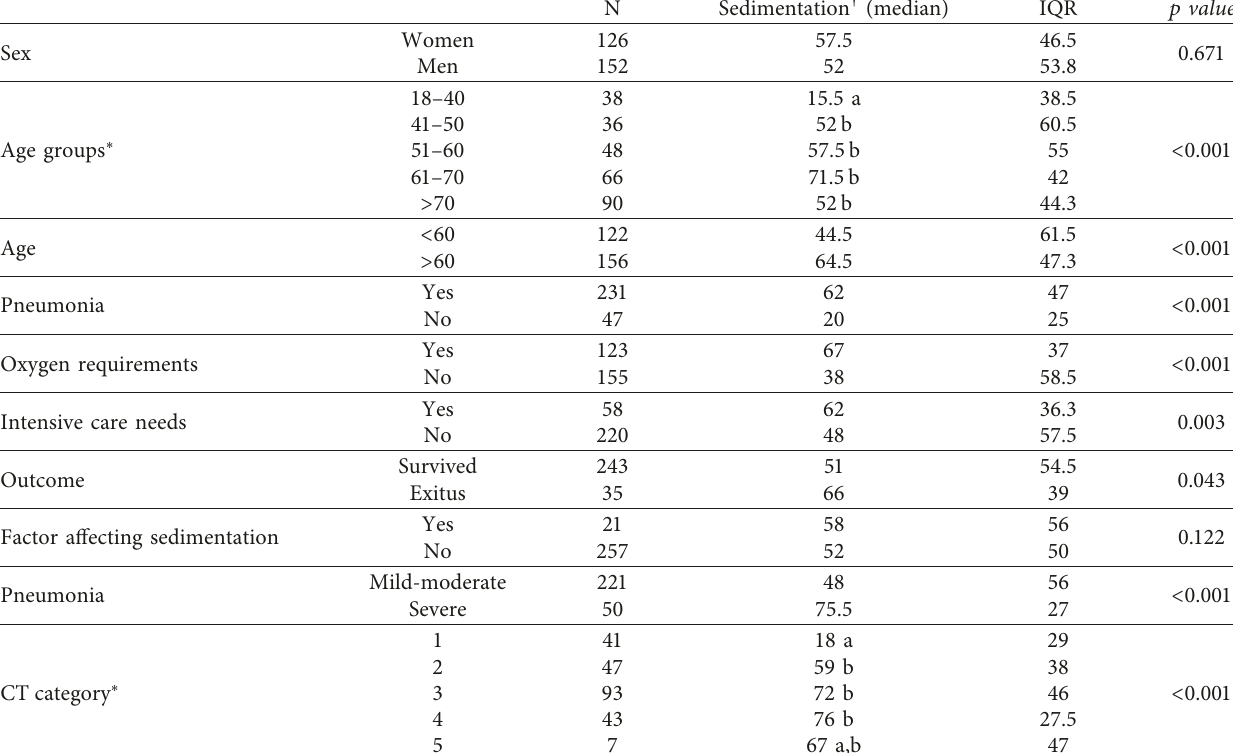
Table 3: Comparison of sedimentation values in various